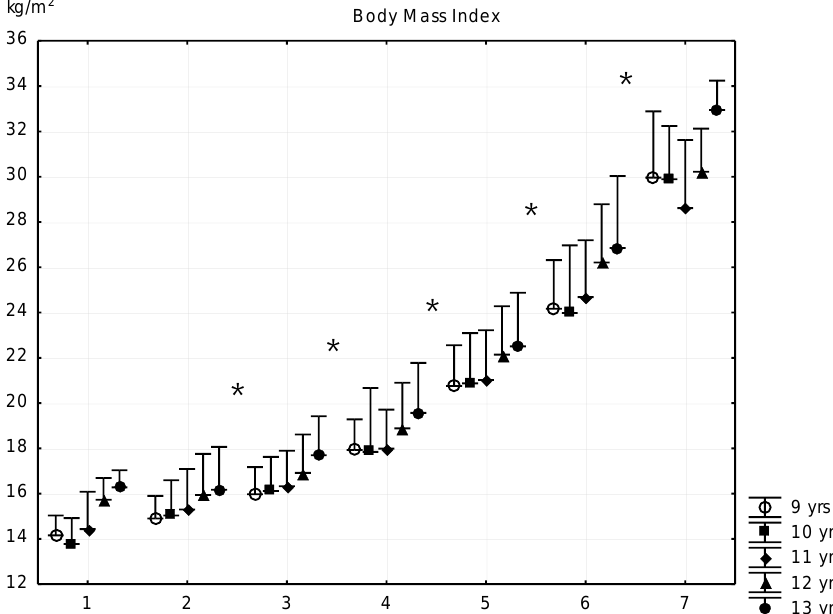
Figure 3. Relationship between body fat percentage and body mass index (mean + SD). 1—F% < 8.00; 2—F% = 8–11.99; 3—F% = 12.00–15.99; 4—F% = 16.00–19.99; 5—F% = 20.00–23.99; 6—F% = 24.00–27.99; 7—F% > 28; F% body fat percentage; * significant difference among subsequent groups, p < 0.05.